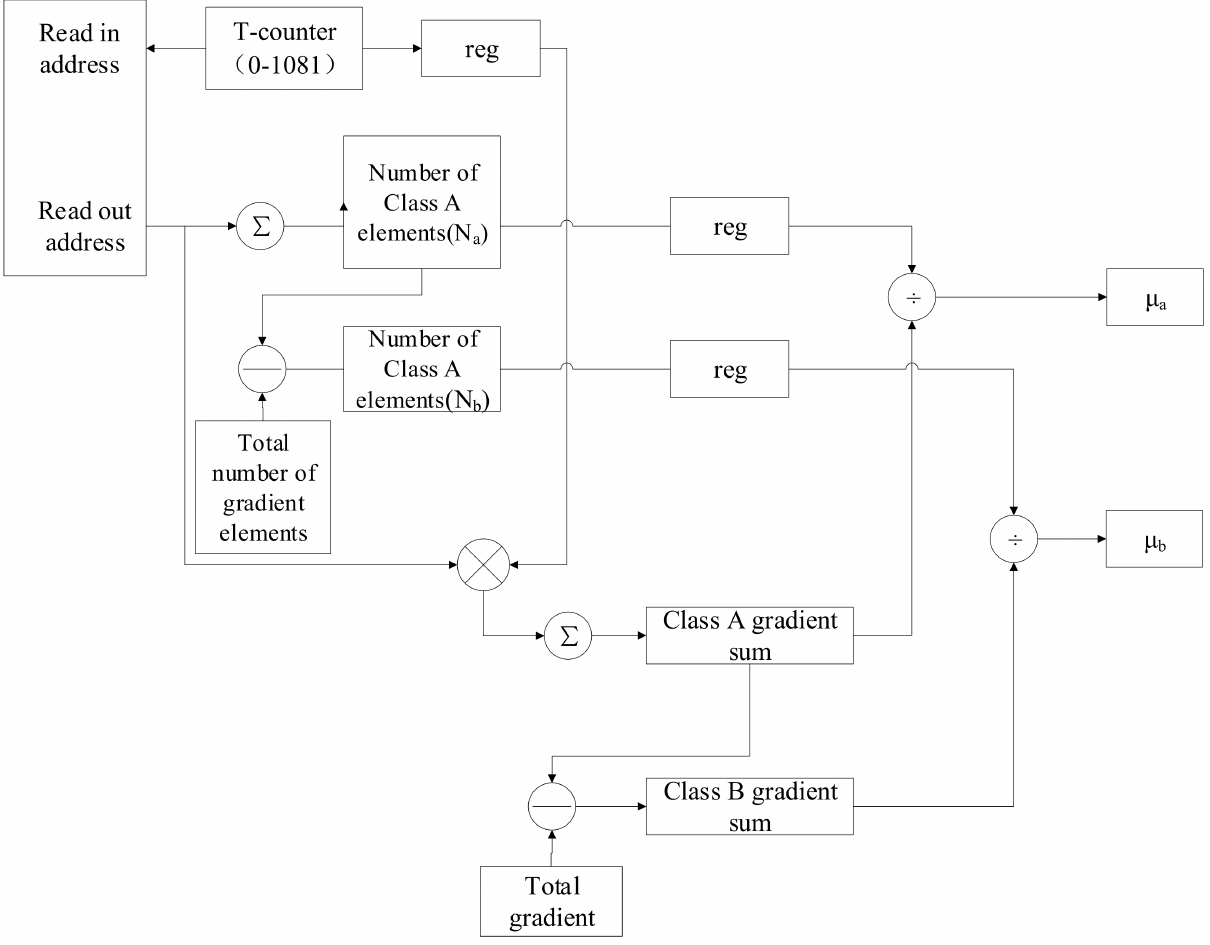
Figure 9. OTSU calculation circuit